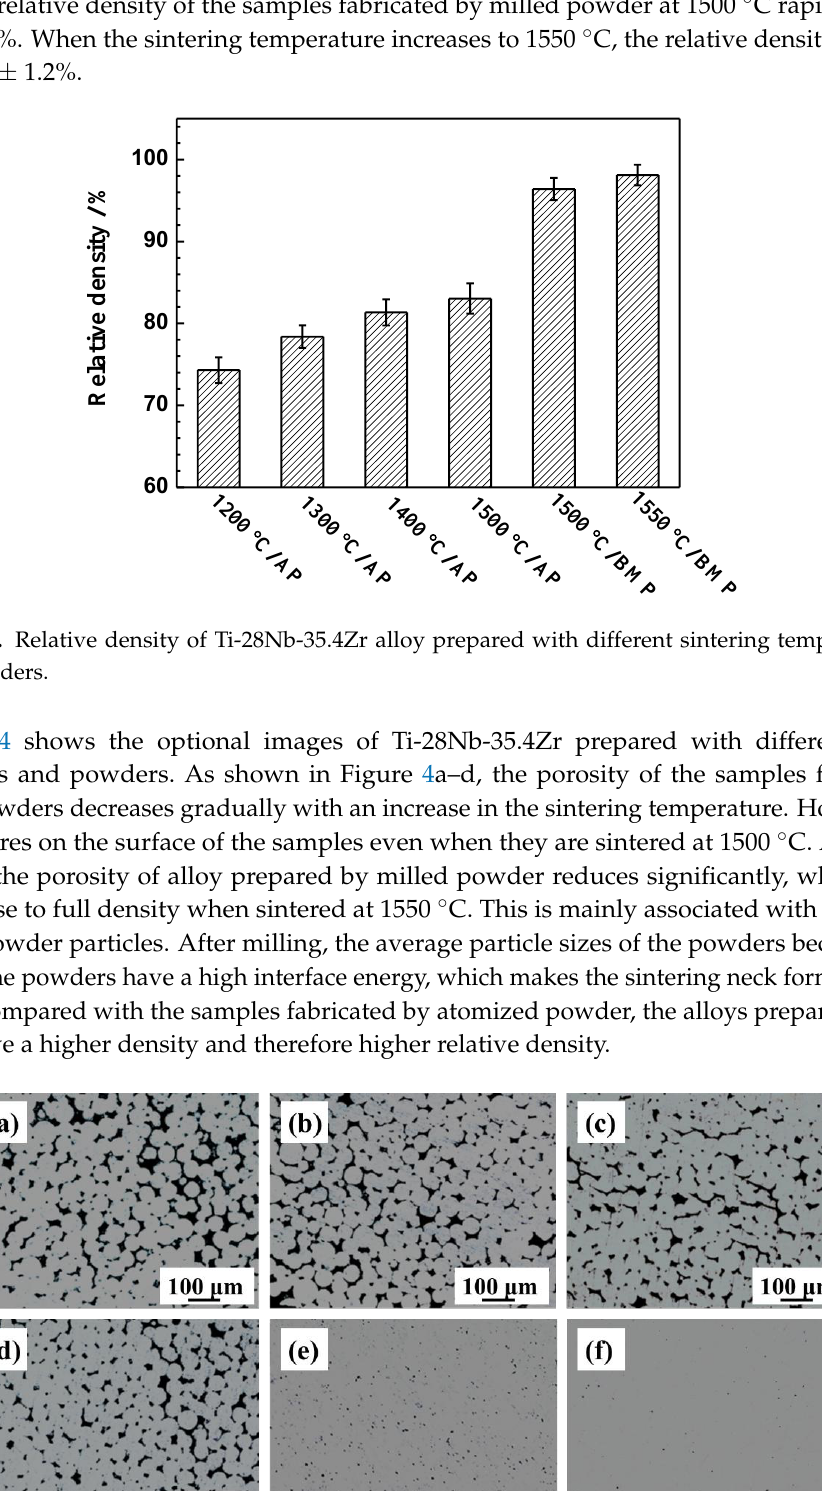
Figure 4. Optical images of Ti-28Nb-35.4Zr prepared with different sintering temperatures and raw powders: ( a ) 1200 °C/AP; ( b ) 1300 °C/AP; ( c ) 1400 °C/AP; ( d ) 1500 °C/AP; ( e ) 1500 °C/BMP and ( f ) 1550 °C/BMP.